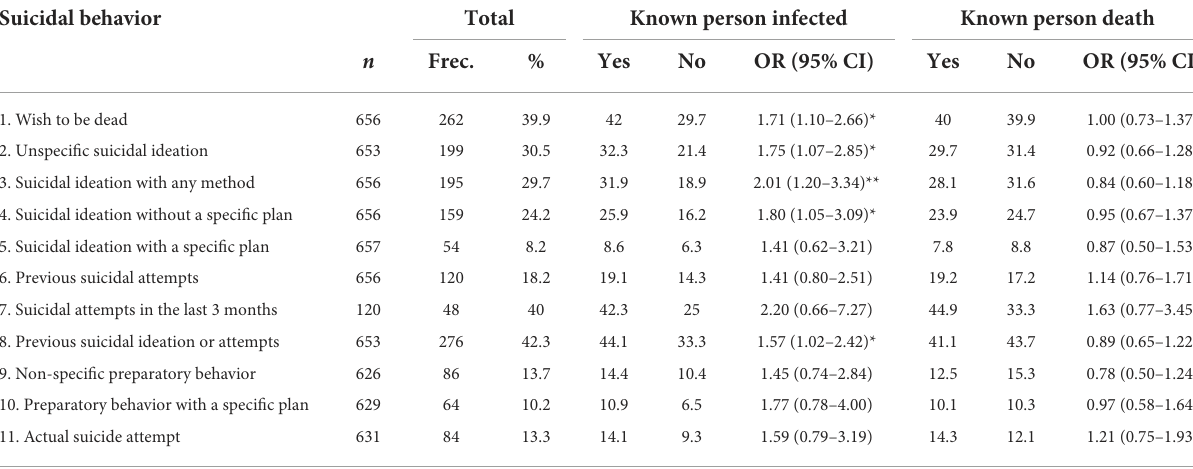
TABLE 5 Association between suicidal ideation and behavior and the consequences of COVID-19 for an acquaintance. Suicidal